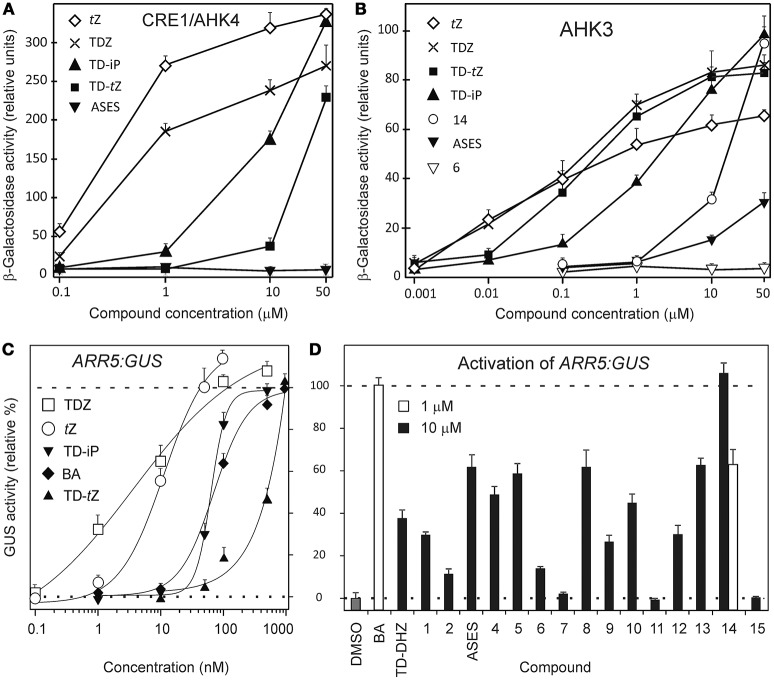
Activation of the cytokinin receptors CRE1/AHK4 (A) and AHK3 (B) by selected compounds in an E. coli receptor activation assay and quantitative evaluation of GUS activity in ARR5:GUS transgenic Arabidopsis plants (C,D). ARR5 is a cytokinin primary response gene. In all bioassays, the activities of the compounds are compared with those of tZ, BA (used as standards) and TDZ. Concentration-dependent curves of ARR5:GUS activity were constructed for the most active compounds (TD-tZ and TD-iP) using Scion image program (C). In (A–C) error bars show s.d. (n = 3). In (D) the activity of compounds was compared to the activity of 1 μM BA, which was set as 100% activation (dashed line). DMSO (0.1%) was used as solvent control (dotted line).Error bars show s.d. of two parallel assays, each consisting of two replicates.